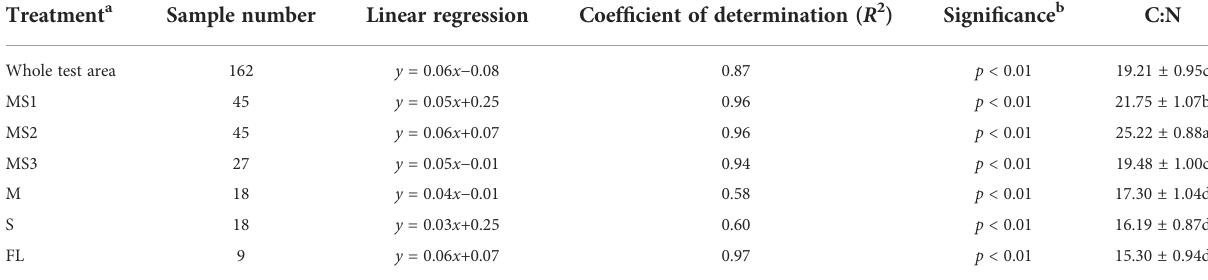
TABLE 4 Soil organic matter and total nitrogen correlation.